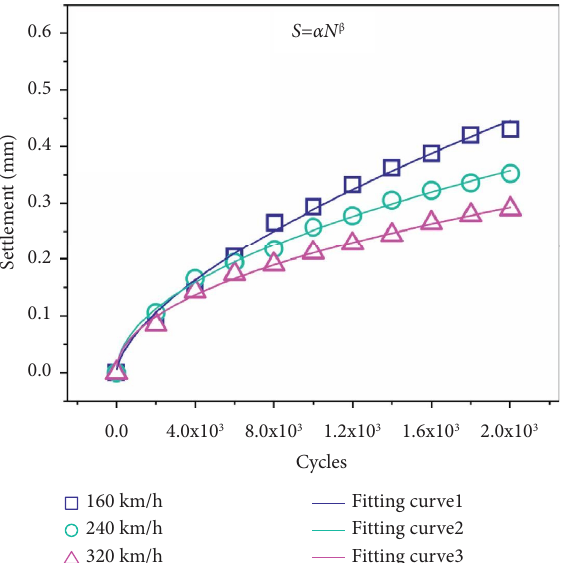
Figure 12: Te cumulative settlement curve of PC-LSPCF.